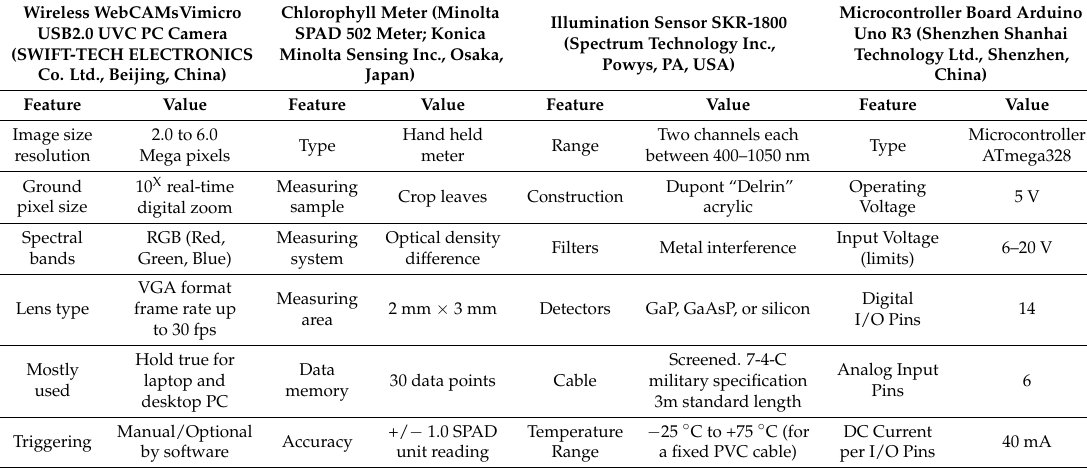
Table 1. Specifications * of the sensors used in this